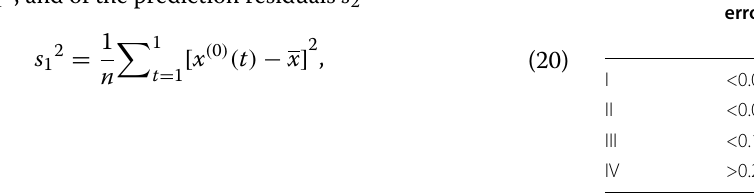
Grade Average relative error